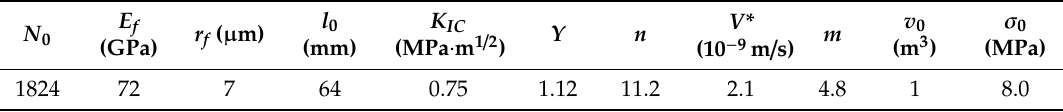
Table 1. Main characteristics of E-glass filaments and